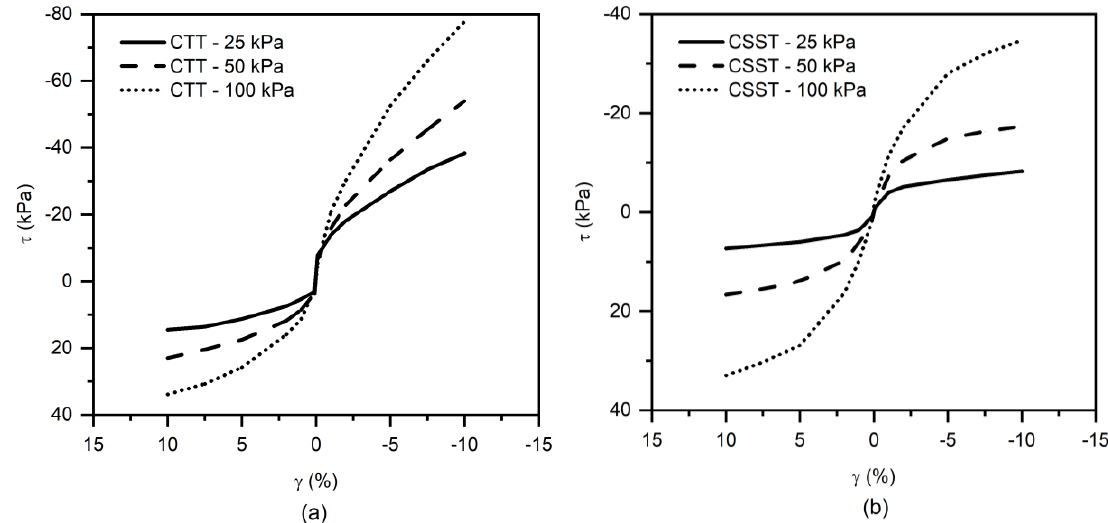
Figure 5. Backbone curves at different consolidation stresses from ( a ) CTTs and ( b ) CSSTs.